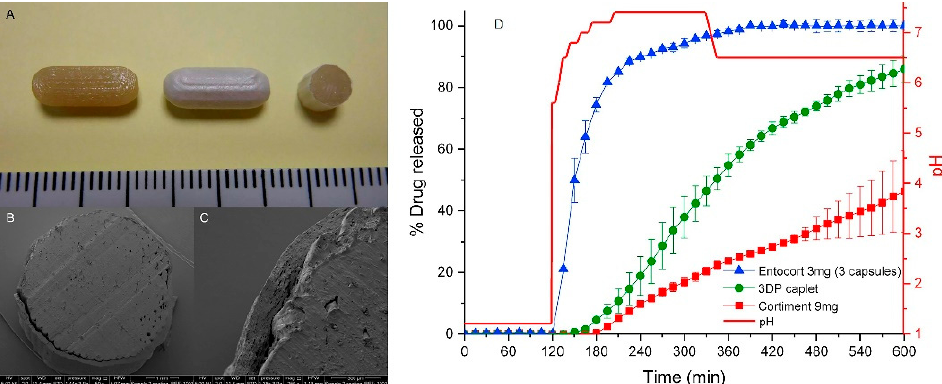
Figure 2. Images of 3DP fabricated caplets ( A ) from left to right: caplet prior to coating, caplet after coating and cross section of coated caplet (scale in cm). ( B , C ) SEM images of internal structure of cross section of a coated caplet. ( D ) Drug release from two commercial products (Cortiment ® , Entocort ® ) and the coated caplets (3DP caplet) in 0.1 M HCl for 2 h followed by physiological bicarbonate buffer under dynamic pH conditions (pH 5.6–7.4 and then 6.5) controlled by the Auto pH System TM. Red line shows the real-time pH values. Figures were adopted with permission from [61], Elsevier, 2015.